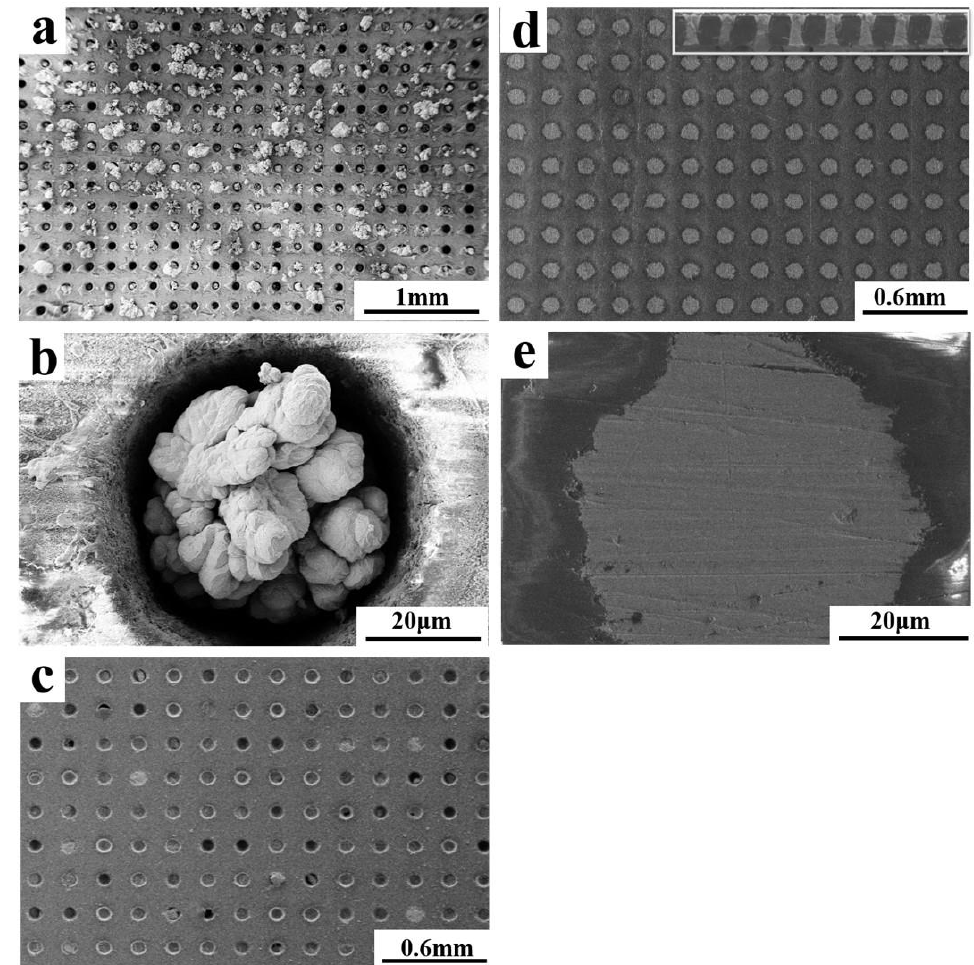
Figure 10. The morphologies of the micro-columns deposited over ( a , b ) 3 hours at −120 mV; ( c ) 15 h via two-step pulsed voltages; ( d , e ) 15 h via three-step pulsed voltages.